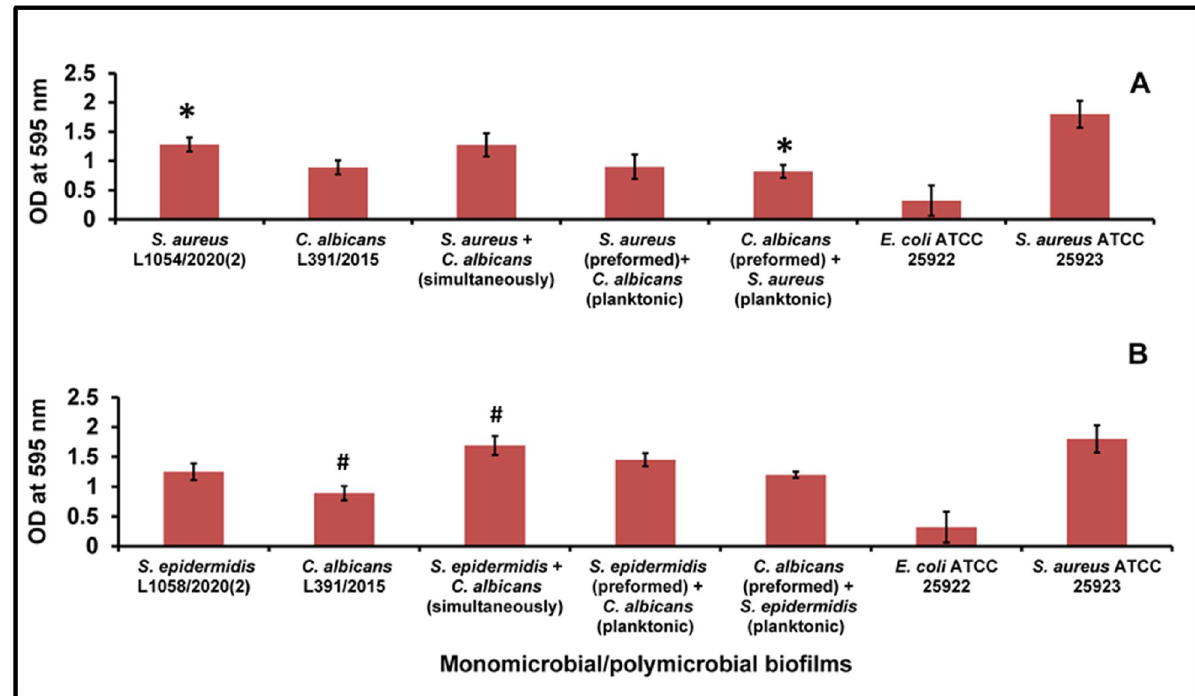
Figure 2. Quantification of polymicrobial biofilm formation in S. aureus ( A ) and S. epidermidis ( B ) with C. albicans by the CV method after 48 h of biofilm formation compared to the monomicrobial biofilms of S. aureus , S. epidermidis and C. albicans . Similar superscripts * and # indicate significant increase (p value < 0.05) in polymicrobial biofilm compared to the respective monomicrobial biofilm at 48 h. Unpaired t-test was used for the calculation of p value. S. aureus ATCC 25923 was used as a positive control and E. coli ATCC 25922 was used as a negative control. Experiments were performed in triplicates. Values represent crystal violet absorbance at 595 nm expressed as average ± standard